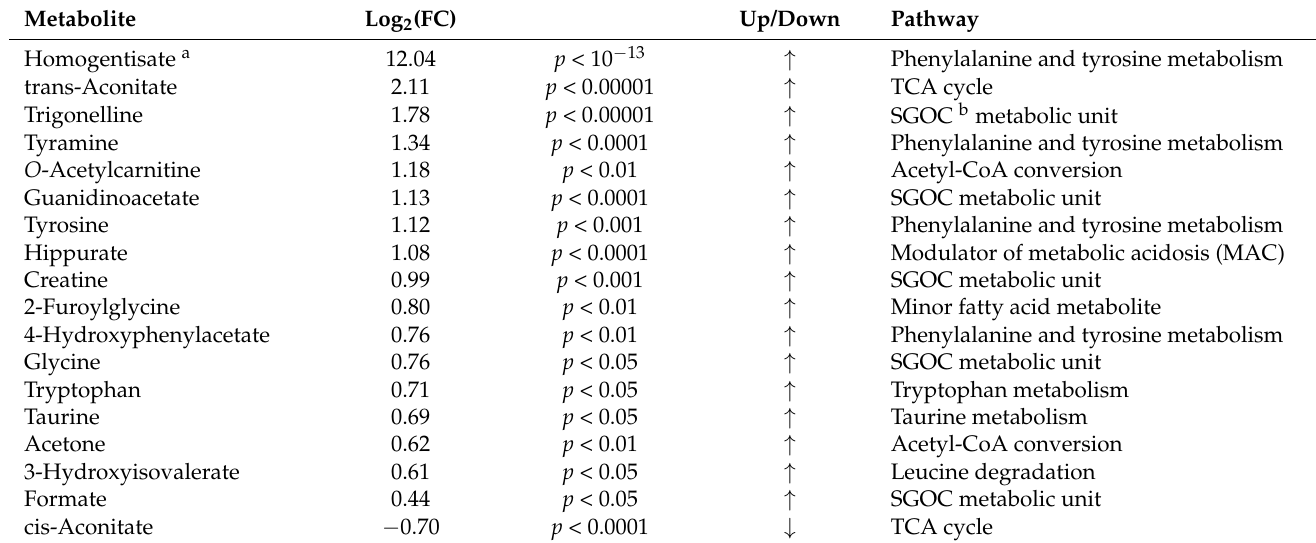
Table 2. Fold changes for metabolites in AKU showing a p-value lower than 0.05 are reported (see Figure 4 for a graphical representation). Fold change is reported as a binary logarithm, and the direction of change is reported as arrows; metabolites are assigned to the relevant